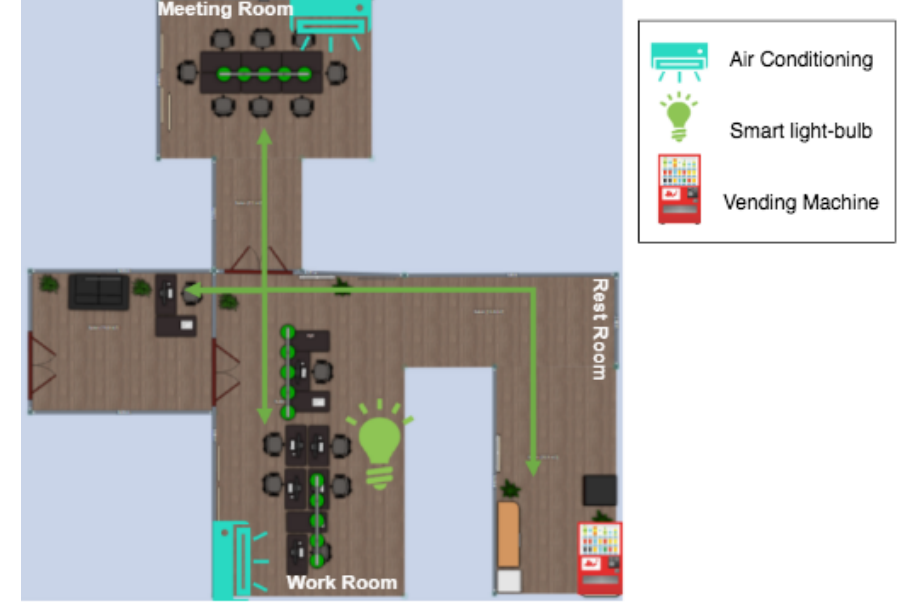
Figure 6. Smart office